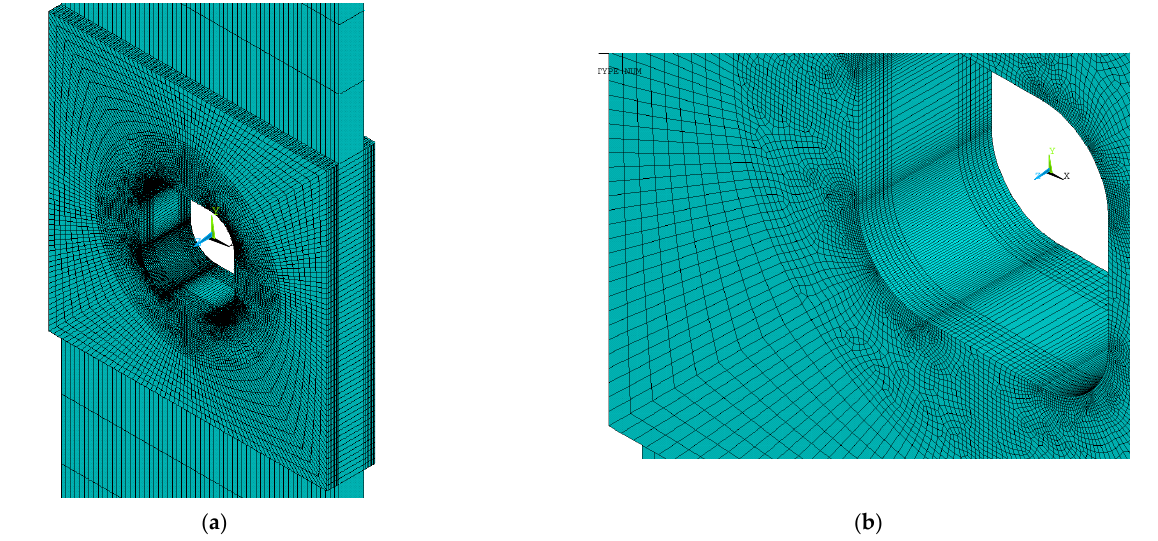
Figure 28. Mesh of finite elements for sample with full width rectangular overlay, real thickness of respective layers shown in magnification: ( a ) overlay area perspective view; ( b ) detail of corner area.